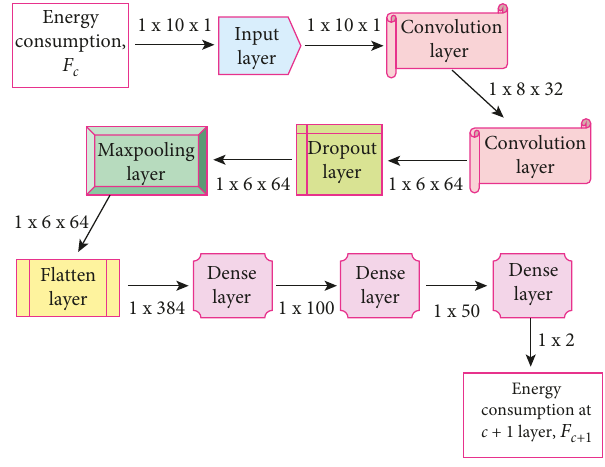
Figure 3: Overview of Deep Q-Network. Table 1: Specification of task flow.